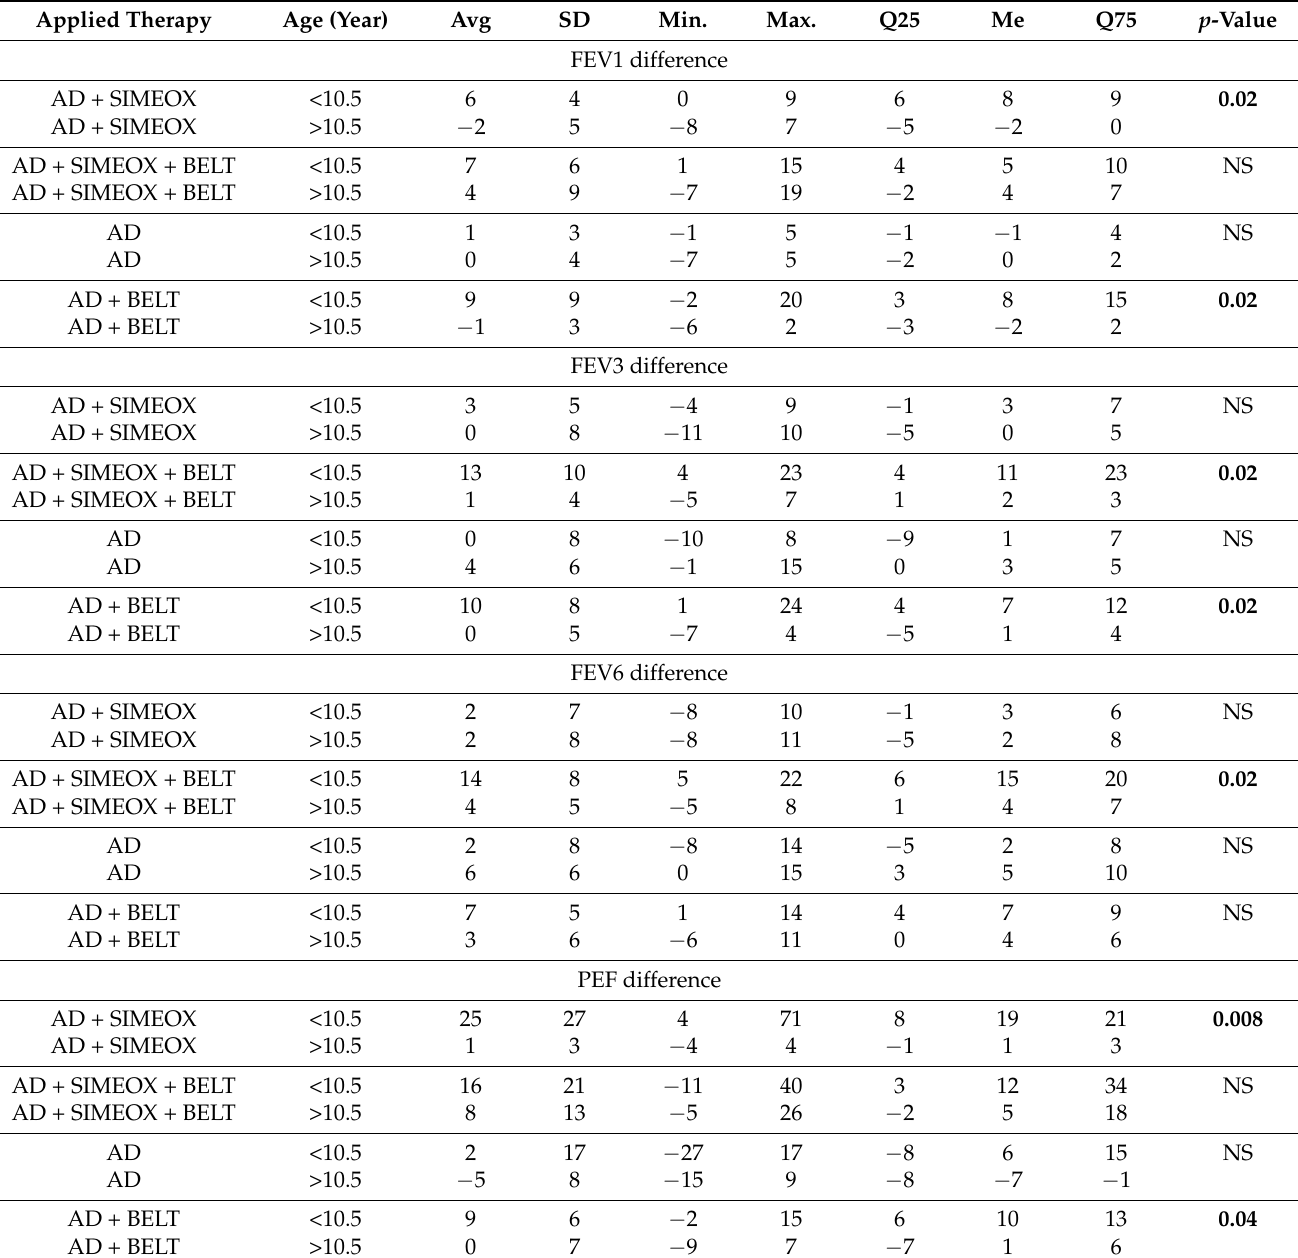
Table 1. Comparison of the differences in individual therapy parameters by